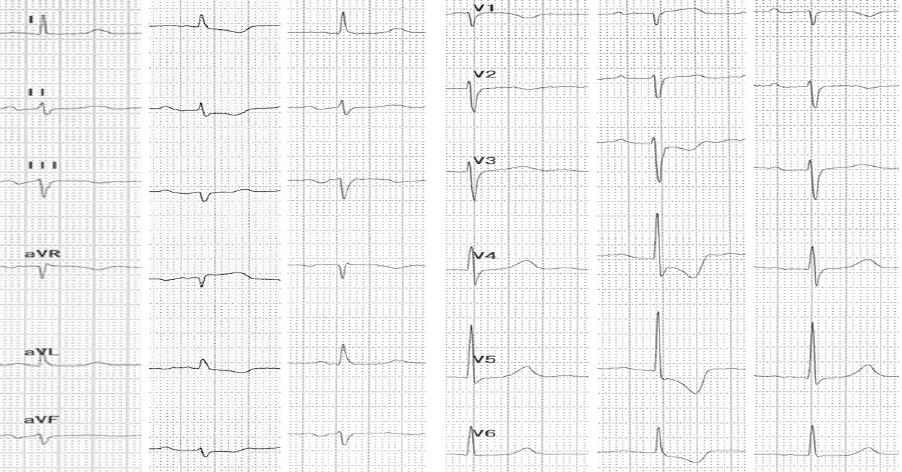
Figure 8. ECG—ST-segment depressions and T-wave inversions.